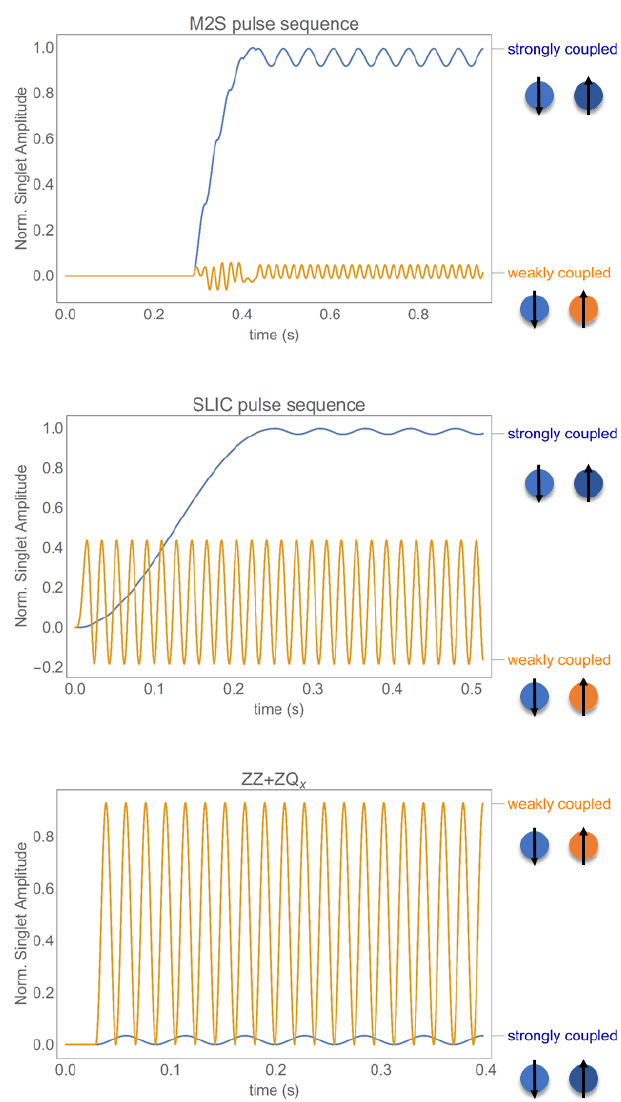
Figure 3. Numerical simulations using SpinDynamica outlining the efficiency of singlet polarisation for M2S, SLIC and ZZ + ZQ x pulse sequences in a two-spin system (by projecting the density operator during the pulse sequence onto the singlet population). The weakly coupled system is described by { (cid:49)ν IS = 50Hz ; J IS = 17 . 4Hz } , while the strongly coupled system features { (cid:49)ν IS = 2 . 8Hz ; J IS = 17 . 4Hz } . For each scenario, only the coherent evo- lution was considered in simulations (no relaxation dampening of the amplitude of source operators or LLS is taken into account). The excitation period is followed by a free-precession evolution af- ter the maximum amplitude for the singlet population was